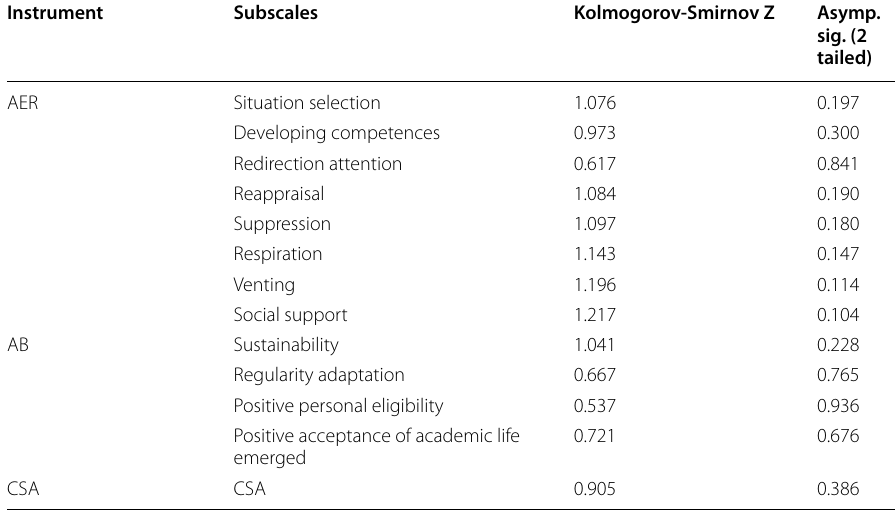
Table 2 The results of Kolmogorov‑Smirnov test Instrument